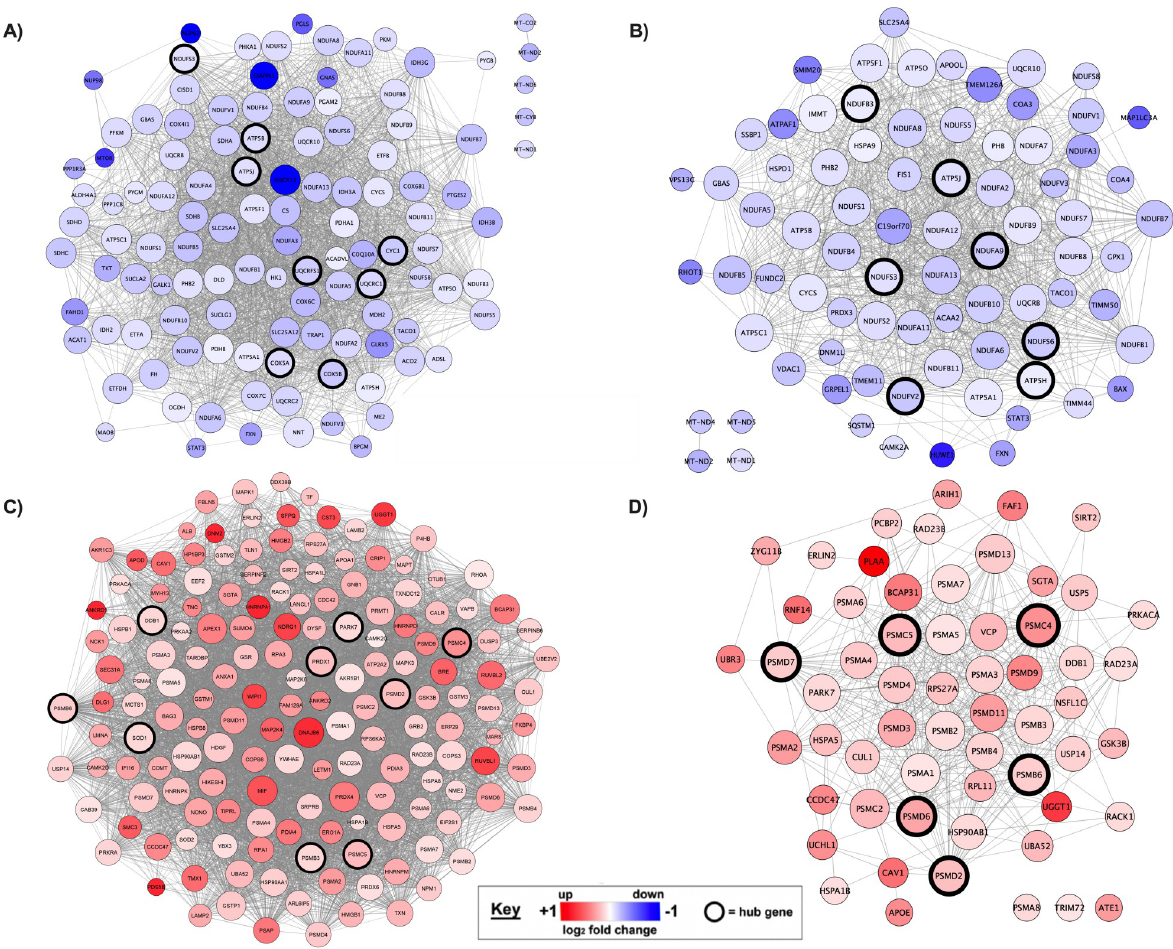
Fig 6. Co-expression networks for gene sets A) Generation of precursor metabolites and energy (GO:0006091), B) Mitochondrion organization (GO:0007005), C) Cellular response to stress (GO:0033554), and D) Proteasomal protein catabolic process (GO:0010498). Nodes correspond to individual proteins enriched at day 14 compared to baseline and edge lines between two proteins represent a co-expression relationship. Colour represents direction of change in expression compared to baseline (red = positive enrichment, blue = negative enrichment) and intensity of colour represents the magnitude of change (darker = higher fold change). Black borders surrounding nodes represent ‘hub’ proteins characterized by the highest 5% of connectivity within the respective gene set.